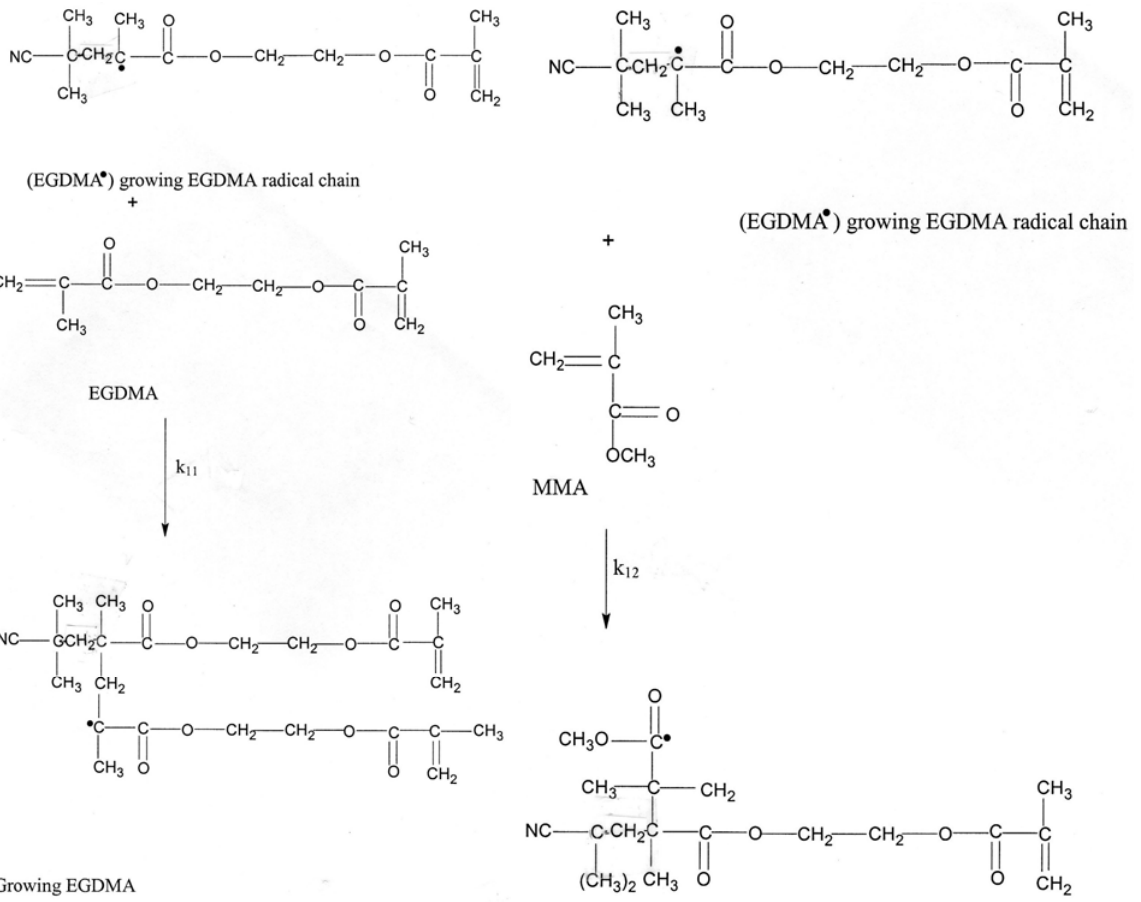
Figure 4. a.(left) Growing EGDMA radical adds its own monomer; b.(right) Growing EGDMA radical adds MMA